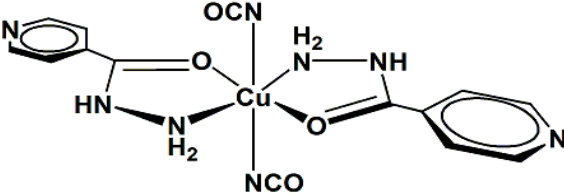
Figure 4. Proposed structure for the [Cu(NCO) 2 (INH) 2 ]·4H 2 O complex ( 3 ).